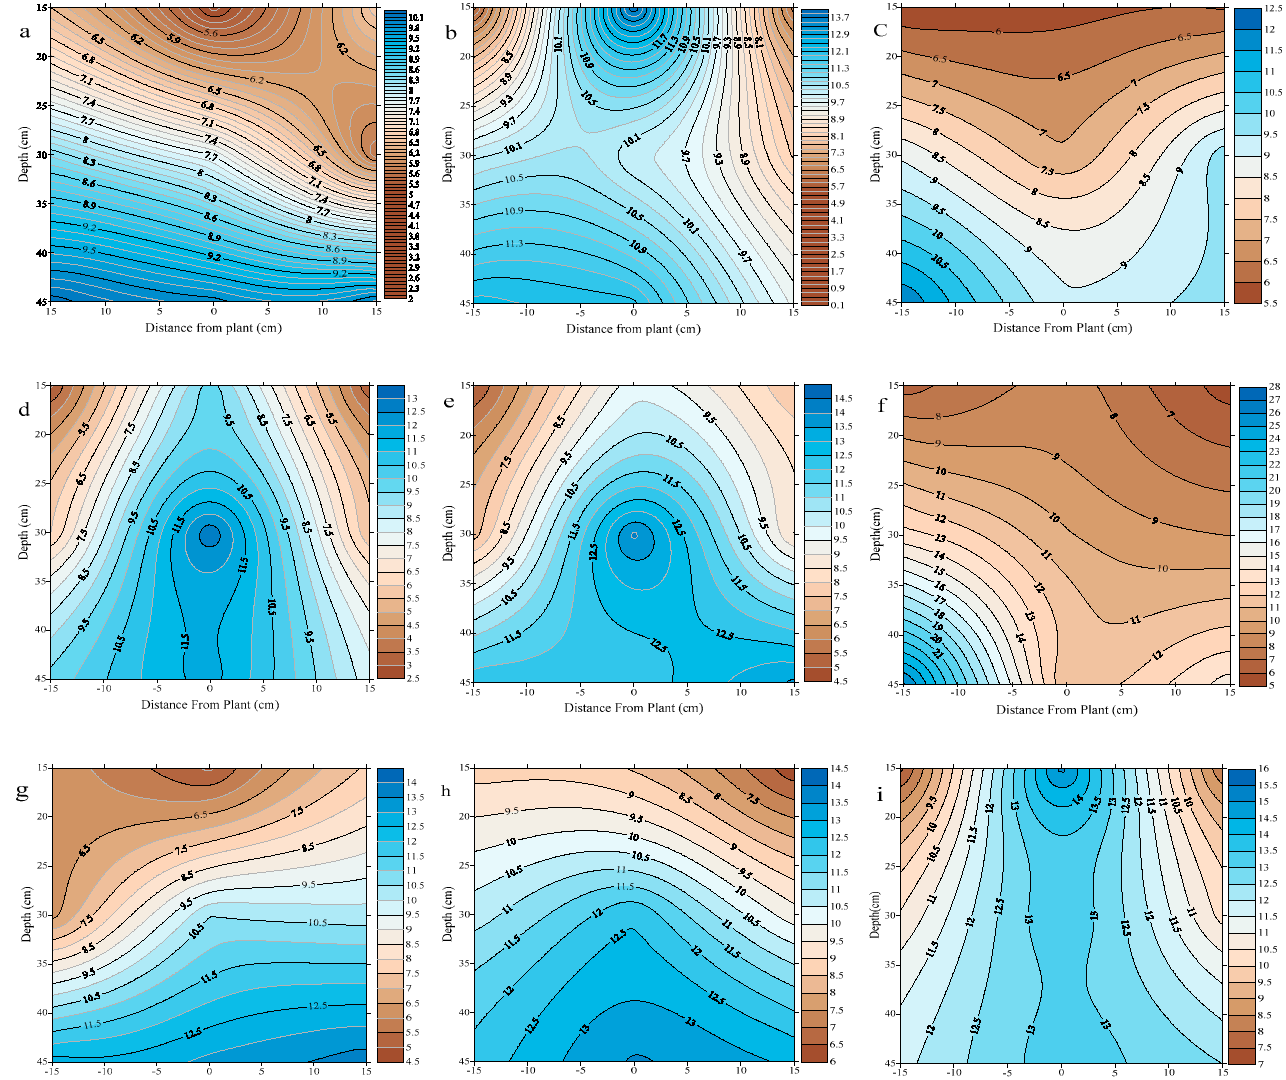
Figure 1. Soil moisture distribution under regulated deficit irrigation for ( a ) 100%, ( b ) 80%, ( c ) 60%, and ( d ) 40% ETc and under partial root drying for four stages, full irrigation treatment ( e ), ( f – h ) without biochar and ( g – i ) with biocahr under saline